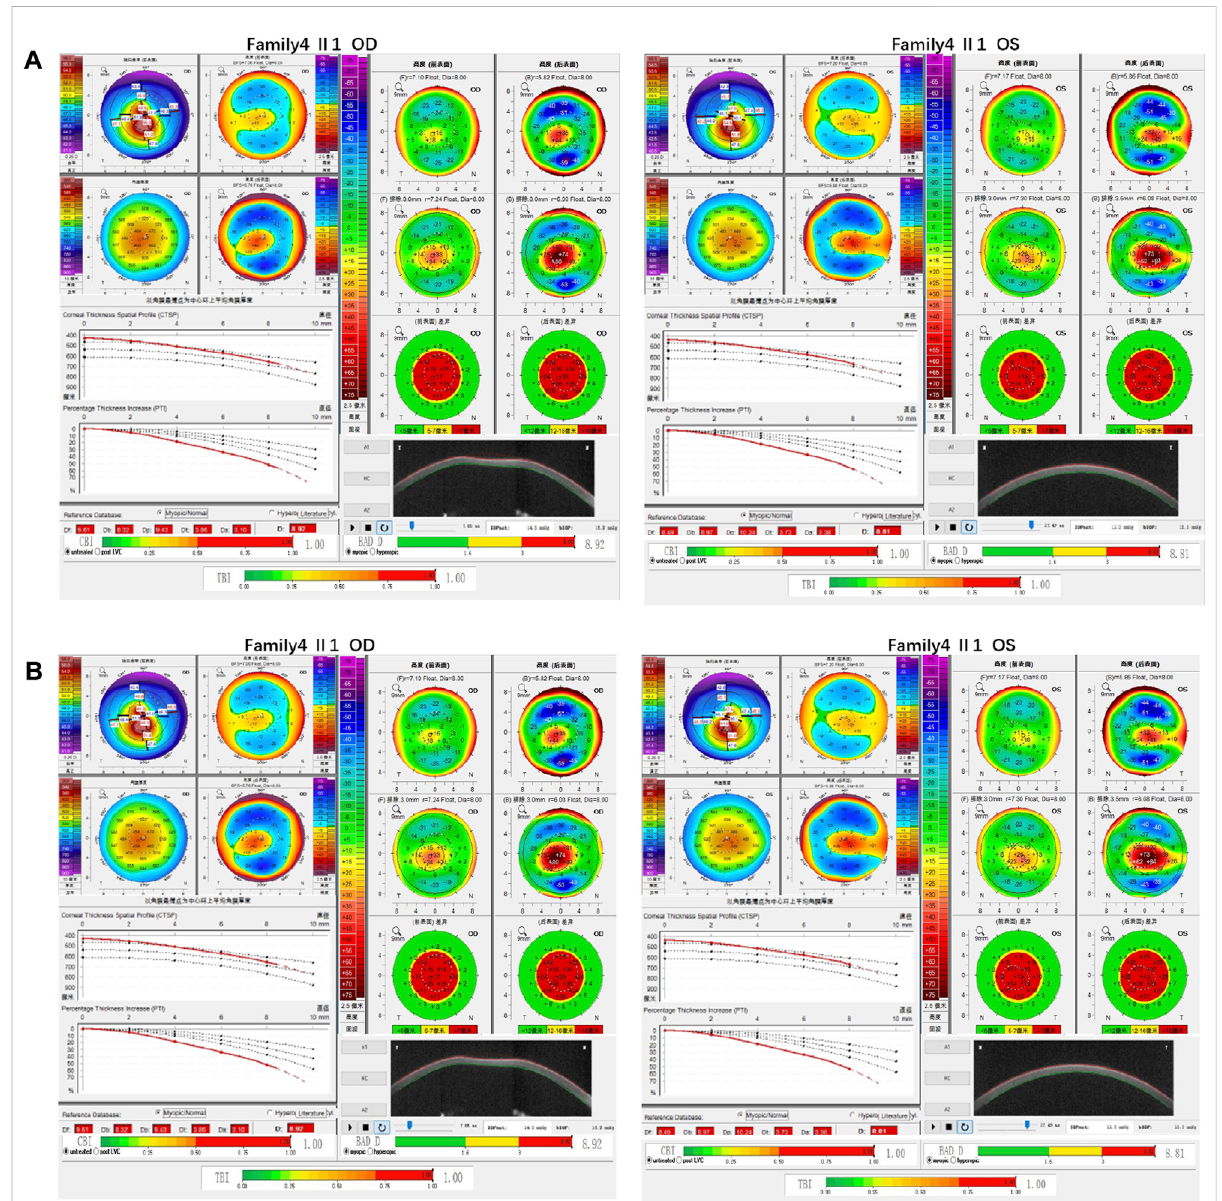
FIGURE 7 Corneal topographic map and corneal biomechanical examination in family4. (A) Kmax, TP, Ef, Eb, Df, Db, Dp, Dt, Da, D, BAD-D, CBI and TBI showing pathological values (red) in the proband. (B) Kmax, Eb, Df, Db, Dp, Dt, Da, BAD-D, TBI showing suspicious values (yellow). CBI and TBI are pathological values (red) in the father of the